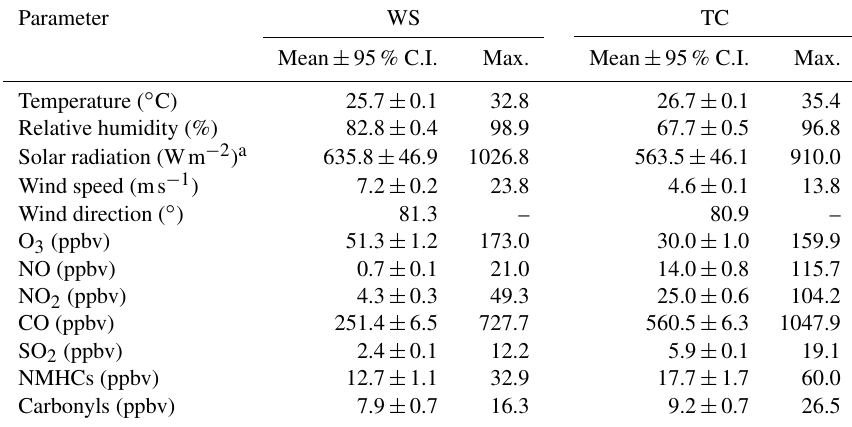
Table 1. Descriptive statistics of meteorological parameters and trace gases at the two sites during the sampling period.